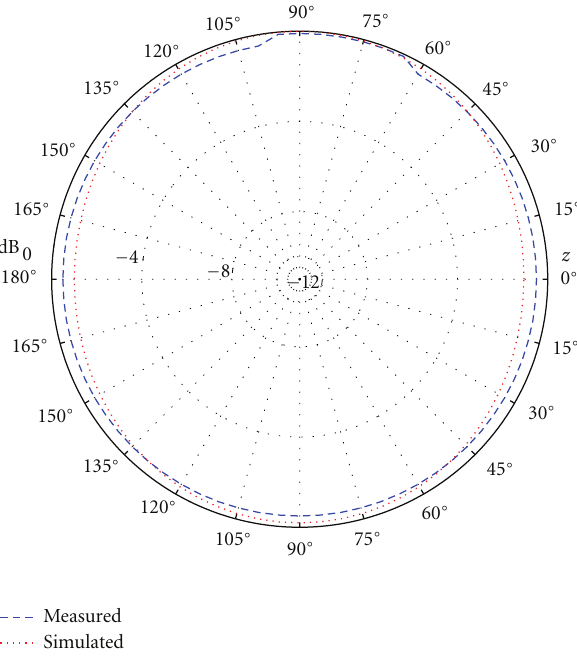
Figure 14: Measured and simulated H -plane ( xz -plane) of the tags radiation pattern, using normalized gain (dB) values, at 860